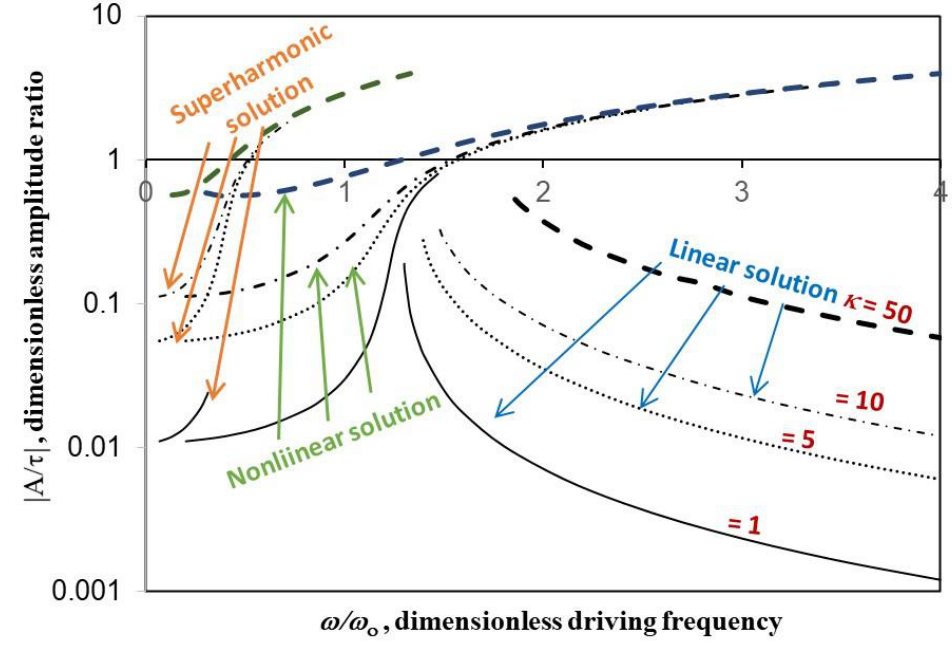
Figure 2. Comparison between the frequency response curves obtained from the proposed method and [18] ( α = 1, β = 2,  = 6) .